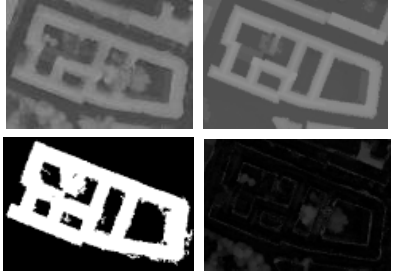
Figure 5.Top: Lidar DSM (right), Worldview-2 DSM (left), Bottom: The absolute difference between two DSMs (right), the sum of two DSMs (left)